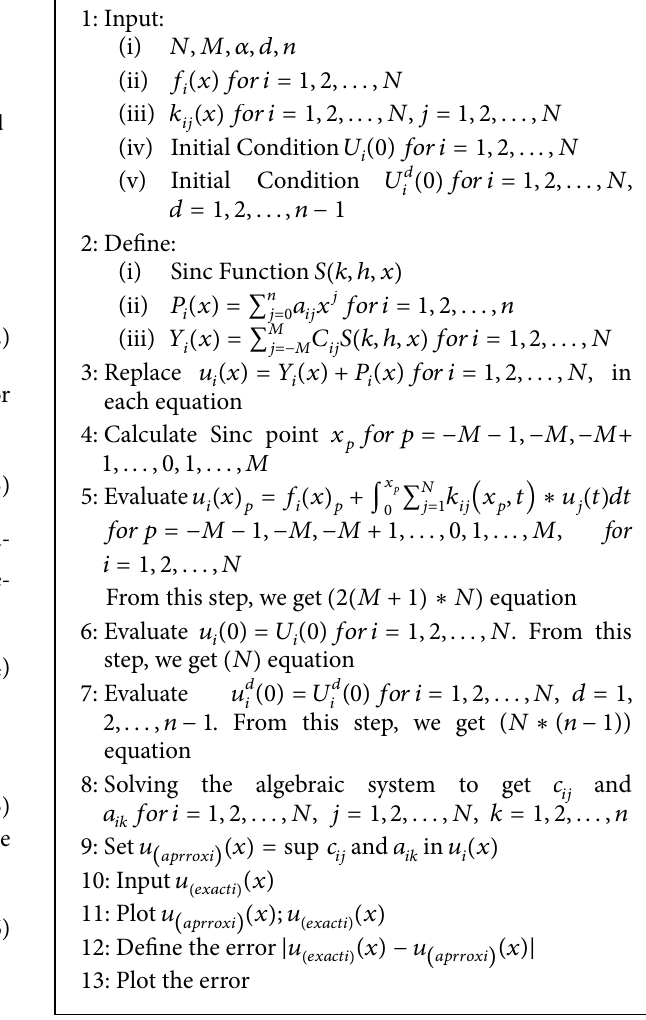
Algorithm 1: Numerical Realization Using the Sinc Collocation